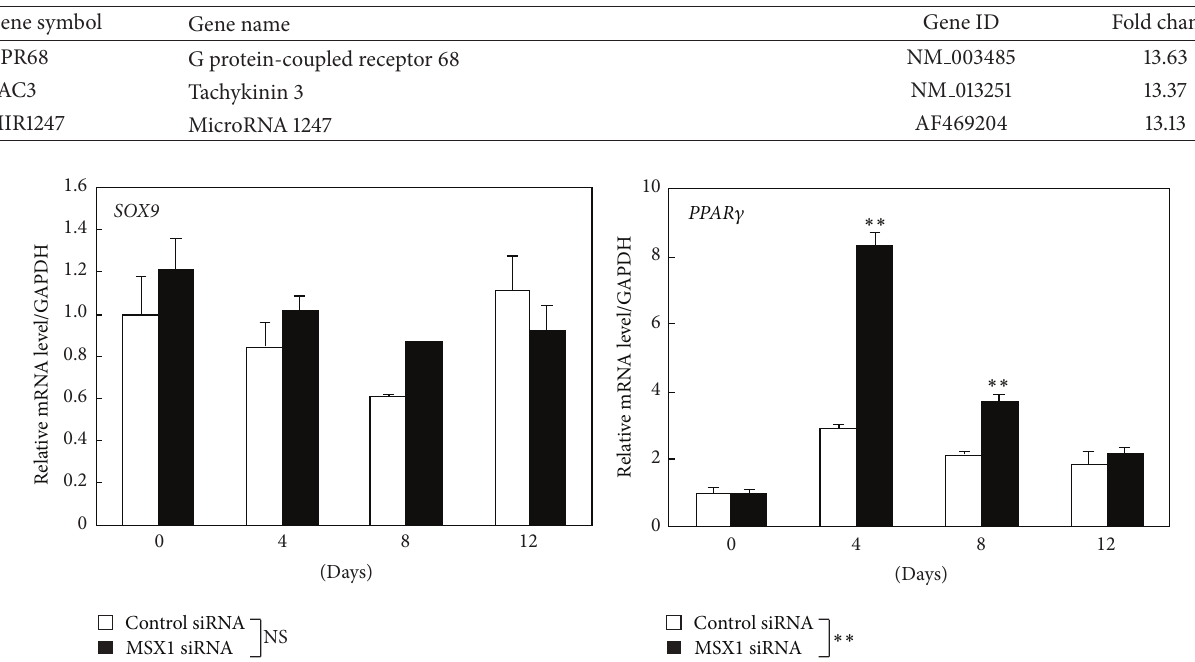
Figure 4: Effects of MSX1 knockdown on the expression of the master genes of chondrogenesis and adipogenesis in hDPSCs. The mRNA levels of SOX9 and PPAR 𝛾 in hDPSCs transfected with MSX1 siRNA or control siRNA were quantified by RT-qPCR on the indicated days. Values are averages ± SD for 3 cultures. ∗∗ 𝑃 < 0.01 ; NS: not